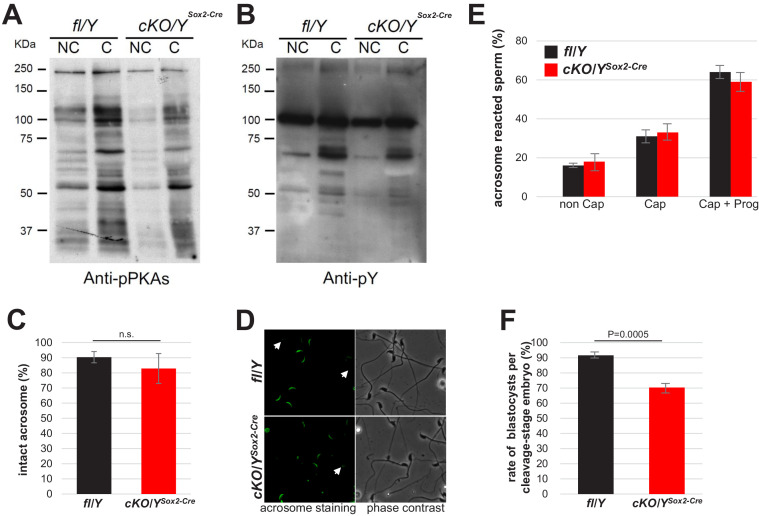
Evaluation of molecular and physiological events related to sperm capacitation.Sperm were incubated at 37°C for 60 min in m-TYH (non-capacitating conditions, NC) or in m-TYH supplemented with 15 mM NaHCO3 and 5 mg/ml BSA (capacitating conditions, (C)). (A) After 60 min of incubation proteins were extracted, subjected to SDS–PAGE, and electro-transferred to PVDF membranes. Then, phosphorylation of PKA substrates was detected by immunoblotting with Anti-pPKAs antibody. Representative image of four independent experiments. (B) Membranes were stripped and then phosphorylation of proteins in tyrosine residues (pY) was detected by immunoblotting with Anti-pY antibody. Representative image of four independent experiments. (C) Evaluation of capacitation through the ability to acrosome react. After 60 min of capacitation in m-TYH Cap medium, sperm samples were incubated with progesterone (Prog, 10 µM) or with DMSO (vehicle) in m-TYH Cap at 37°C for additional 30 min, and then acrosomal status was assessed by Alexa Fluor 488-PNA staining. Acrosome reaction after 90 min in non-capacitating (Non Cap) conditions was also evaluated. Results are indicated in percentage of acrosome reacted sperm. n = 4, at least 200 sperm per sample were counted. Values represent the mean ± s.e.m. (D) Evaluation of acrosomal status by Alexa Fluor 488-PNA staining. Representative fluorescence images of the acrosomal staining (left panel), and their corresponding phase contrast images (right panel). (E) Sperm displaying uniform fluorescence along their acrosomes were counted as intact. n = 9, at least 200 sperm per sample were counted. Values represent the mean ± s.e.m. (F) Rates of blastocysts per cleavage staged embryos sired by fl/Y or cKO/YSox2-Cre sperm in IVF.